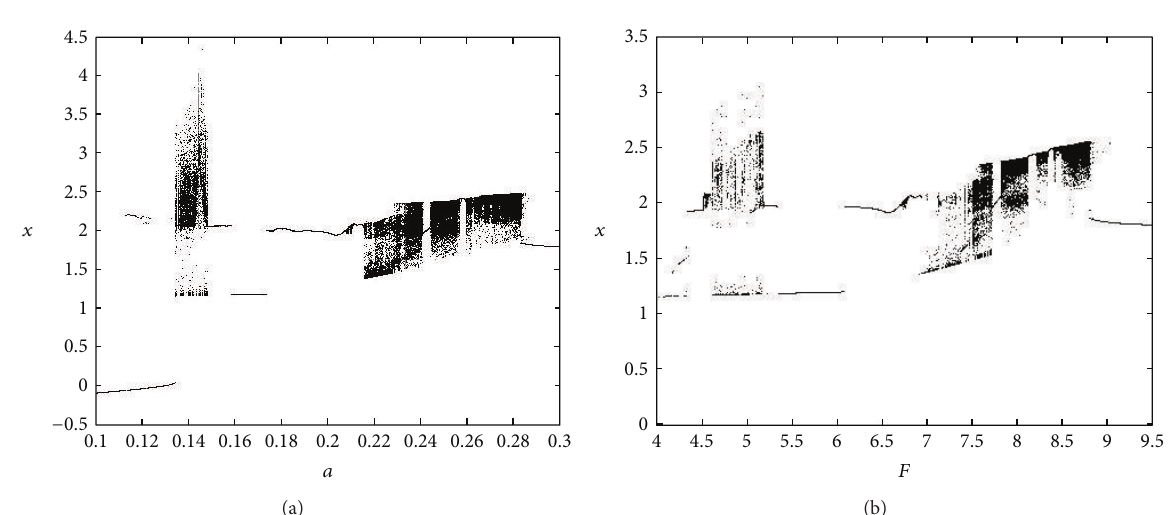
Figure 12: (a) The bifurcation diagram about 𝑎 . (b) The bifurcation diagram about 𝐹